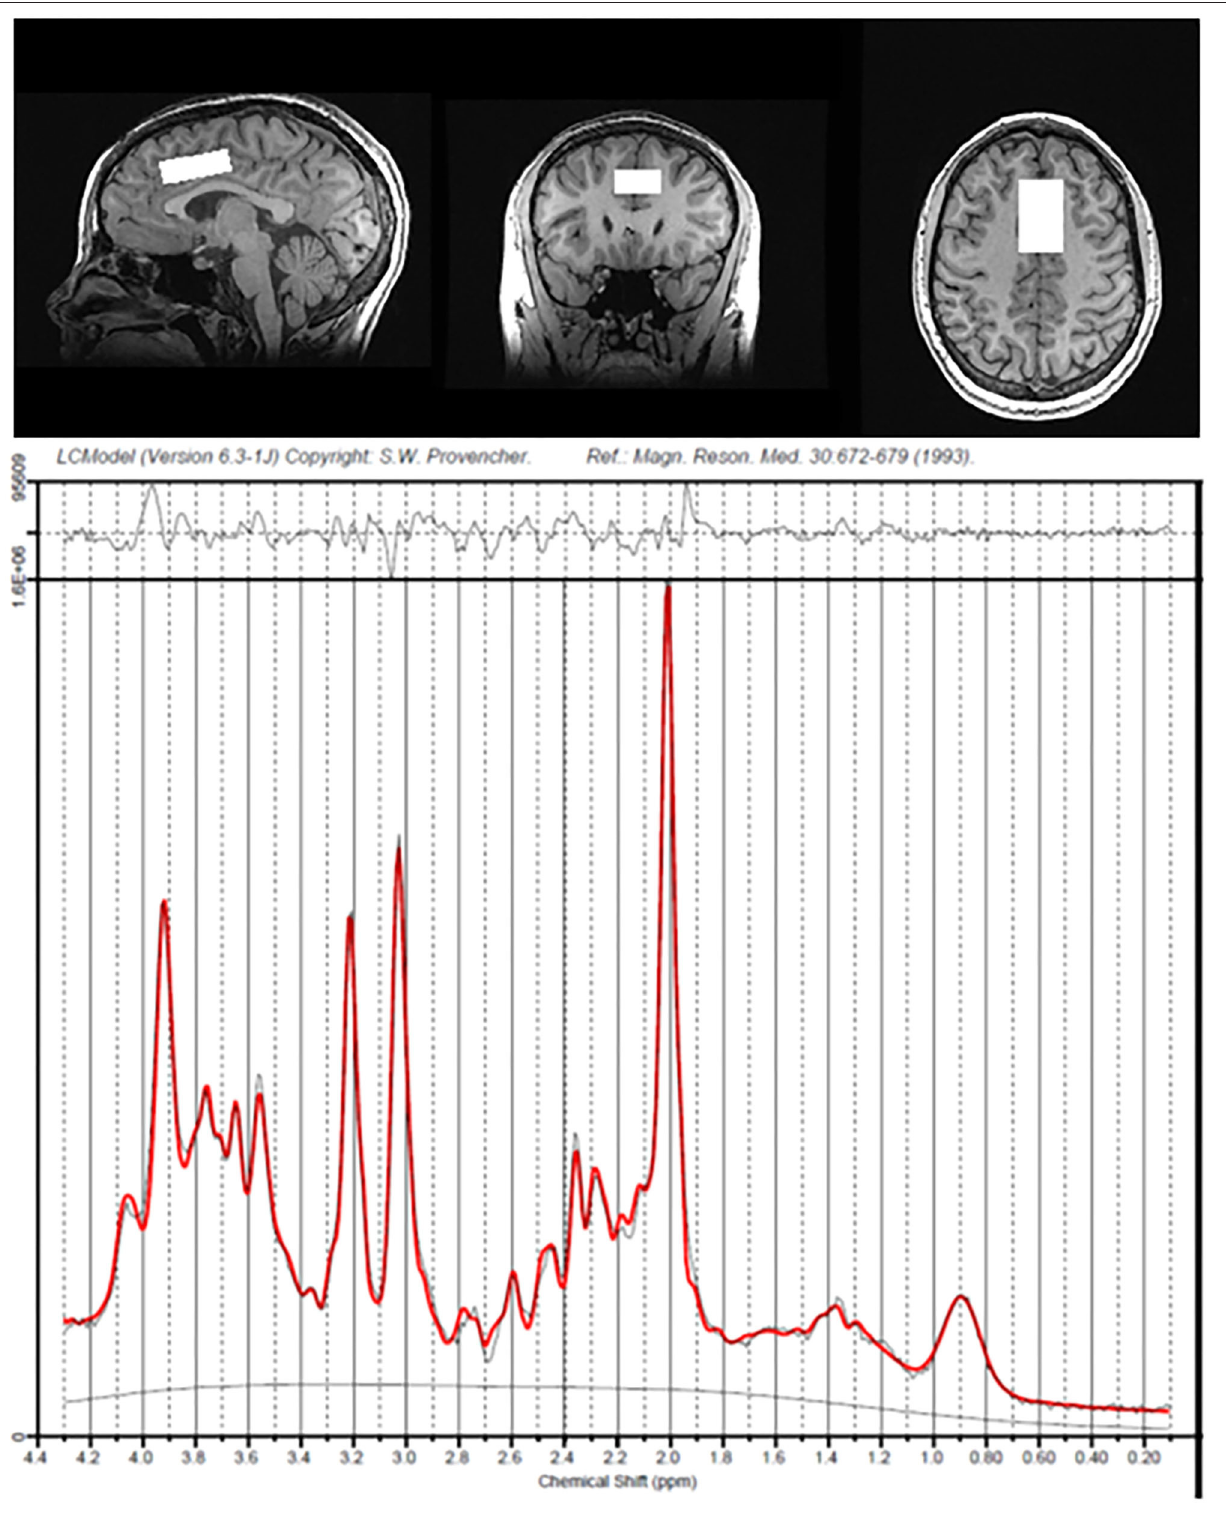
FIGURE 1 | Voxel placement of dorsal anterior cingulate cortex and spectra data from a representative participant.